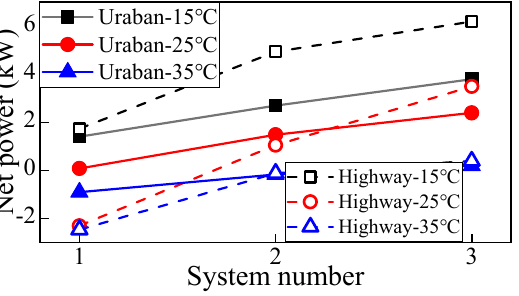
Figure 20. Net power of systems under urban and expressway conditions at different environmental temperatures.